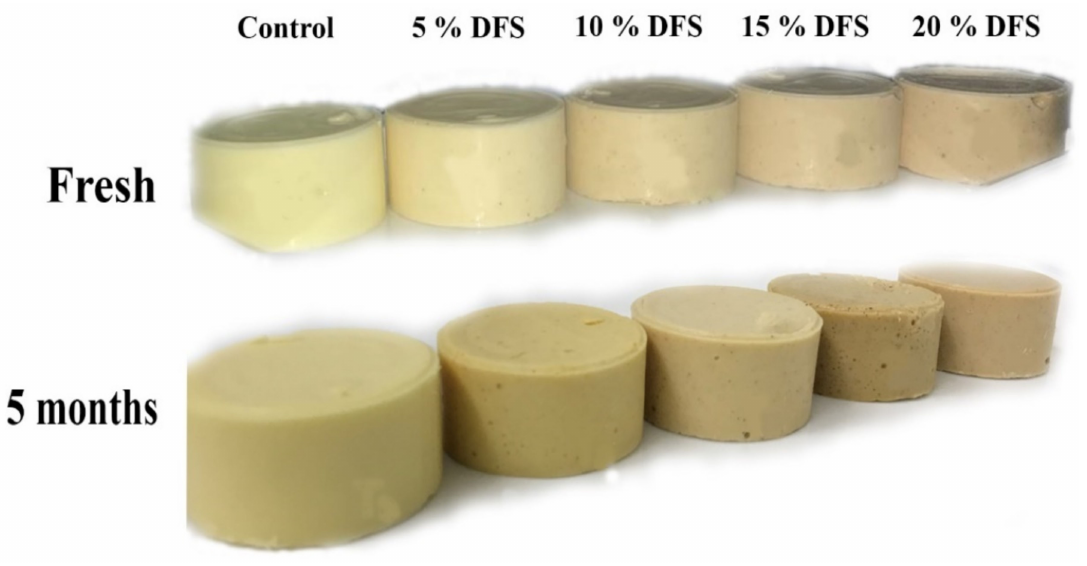
Figure 6. The visual appearance of block-type processed cheese fortified with DFS as a partial substitution for